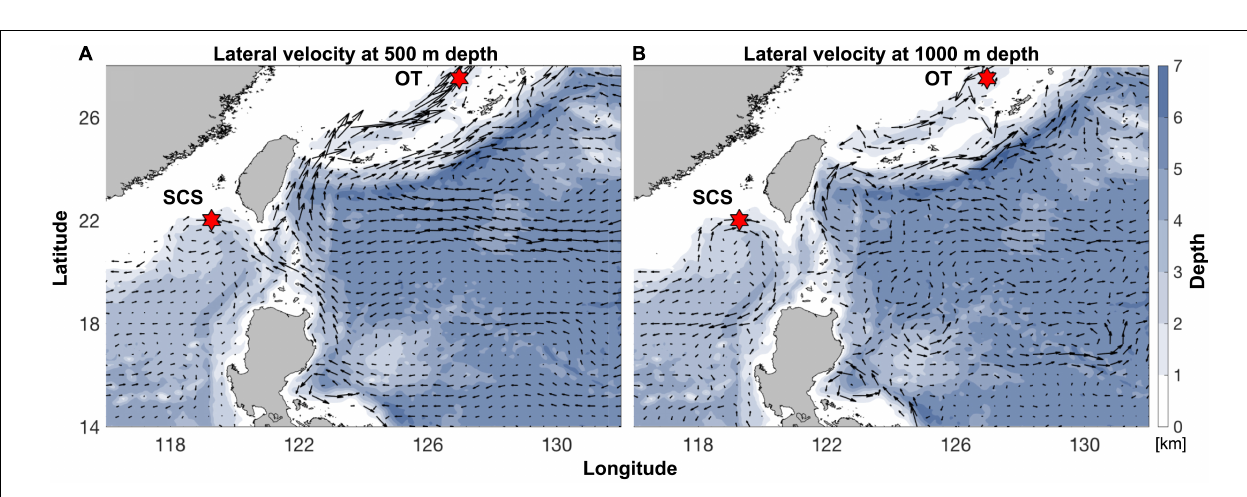
FIGURE 5 | Annual-mean lateral velocity vectors, denoted by black arrows, at (A) 500 m depth and (B) 1,000 m depth laid upon the bathymetry (color contours; unit: km) in our analysis region. Sampling sites of the SCS and the OT are indicated by the red hexagrams. Datasets are based on the HYCOM + NCODA Global 1/12 ◦ Reanalysis (experiment sequence: